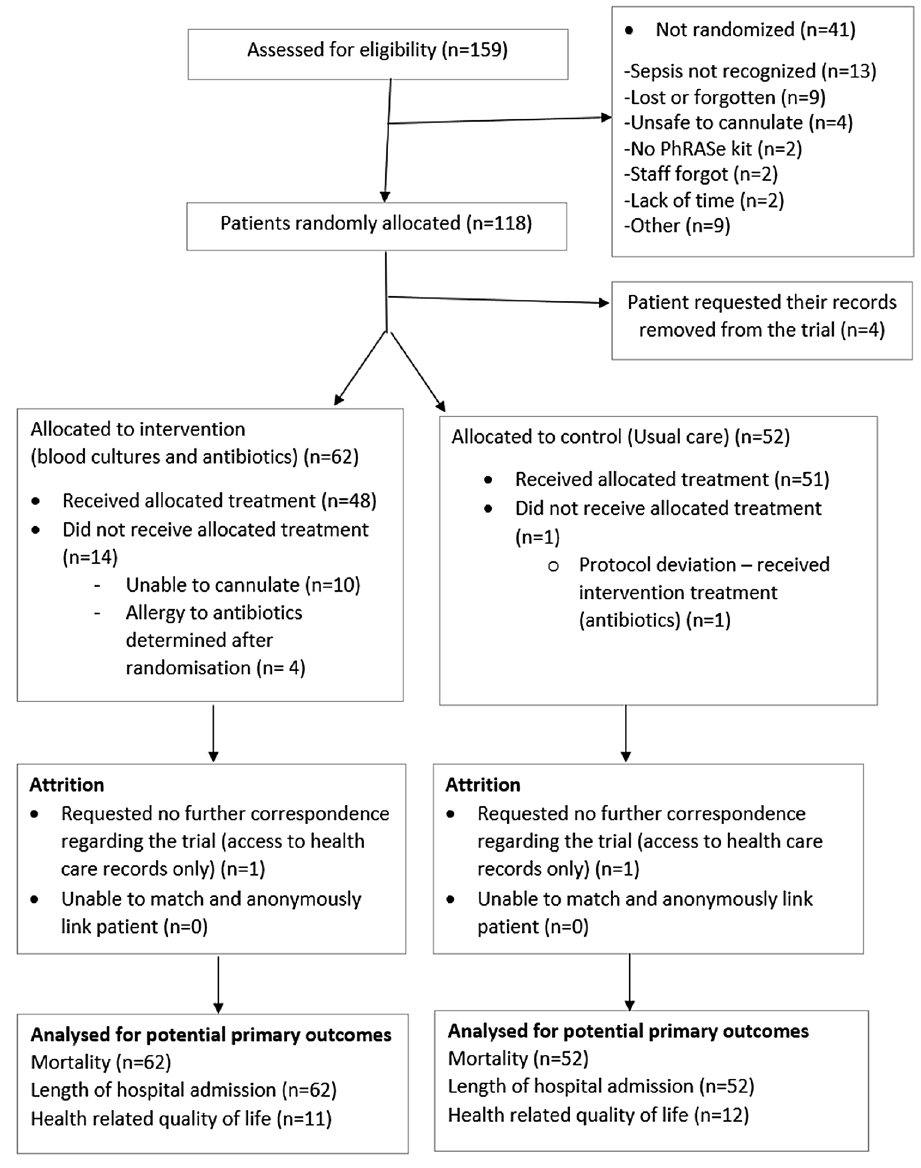
Figure 1. CONSORT flowchart.